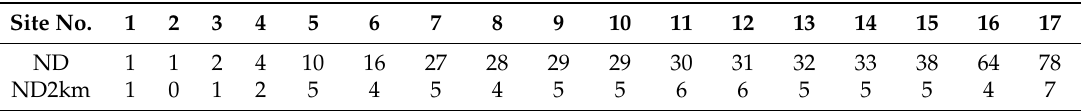
Table 2. Number of dams in the Corgo river above the examined site (ND) and more than 2 km upstream of the examined site